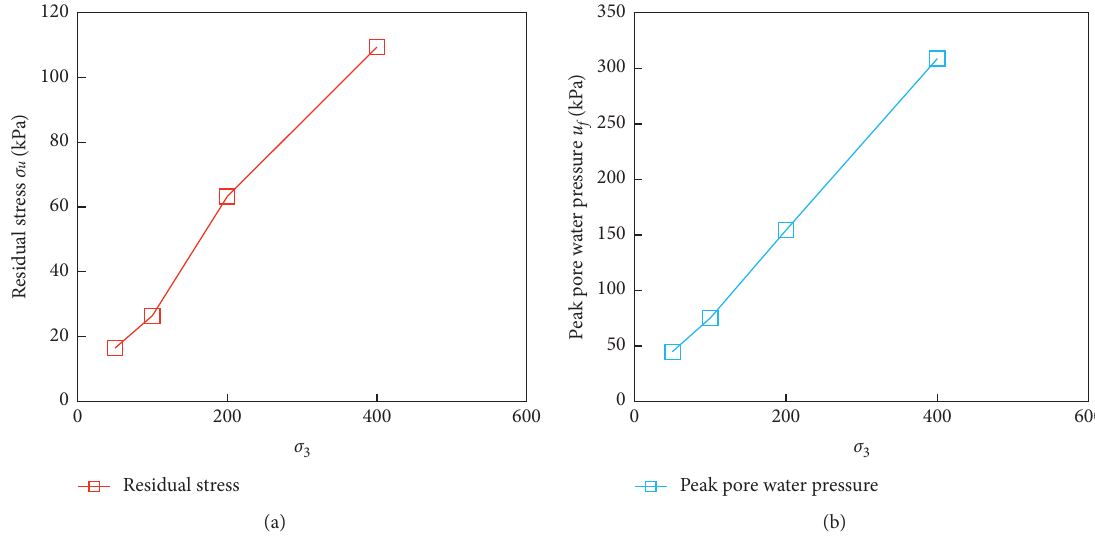
Figure 9: (a) Relationship between σ u and σ 3 and (b) relationship between u f and σ 3 under T